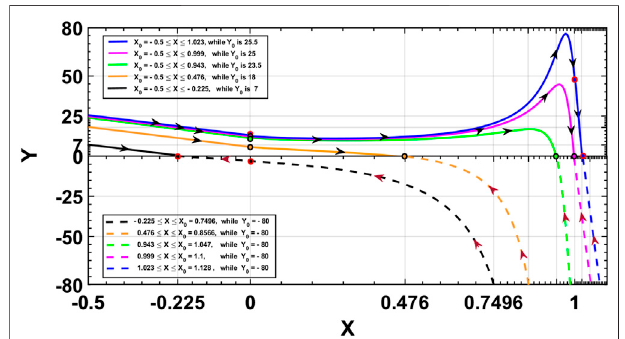
FIGURE 9 | Phase portraits showing the charge evolution from left to right for Y 0 > 0 and from right to left for Y 0 < 0 under different initial conditions. The lack of symmetry is noticeable within the bulk of the device.